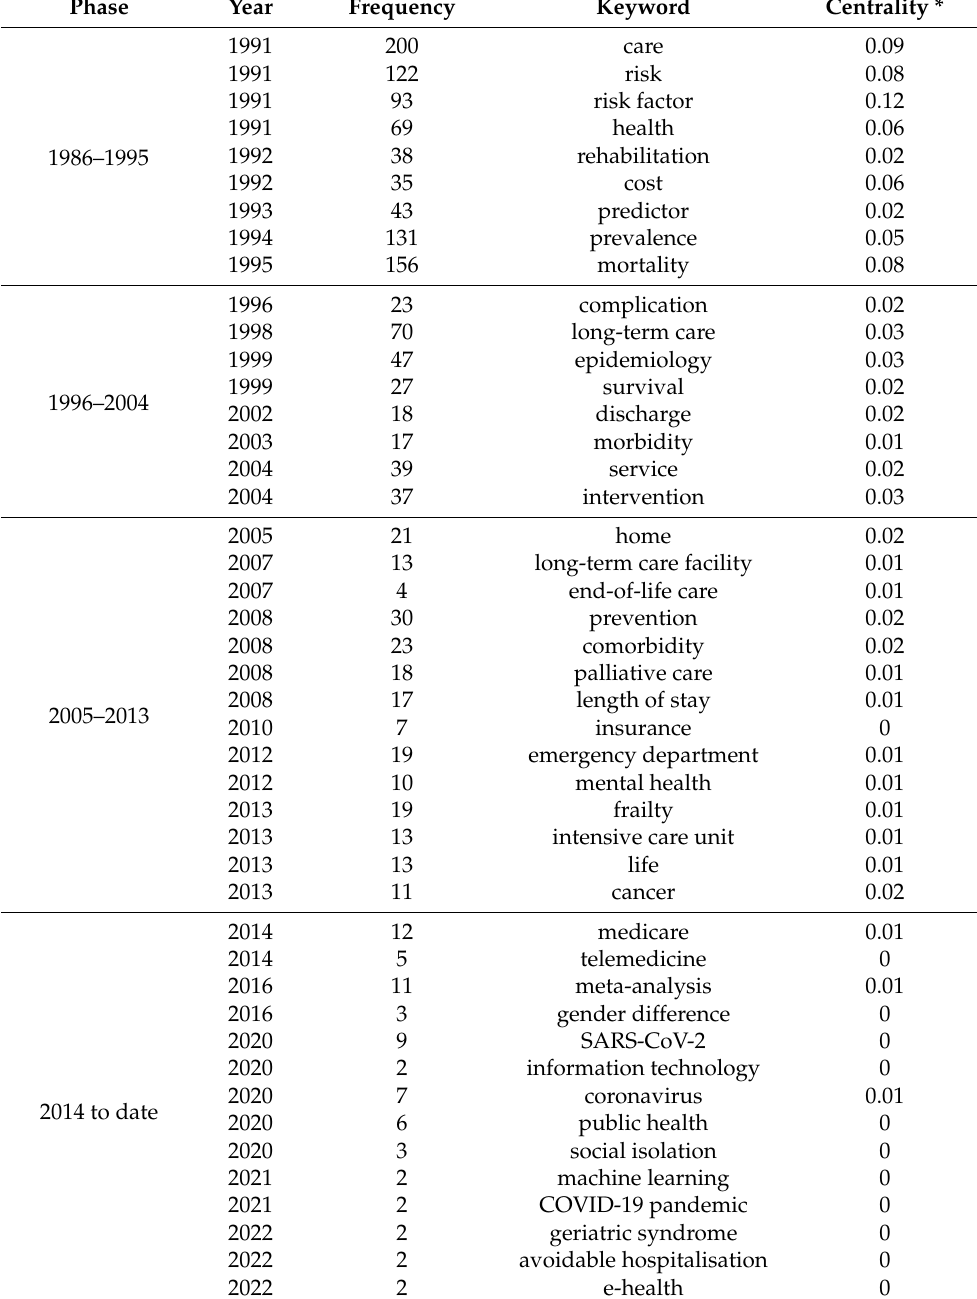
Table 3. Centrality and frequency of FCMNCE research high-frequency keywords.